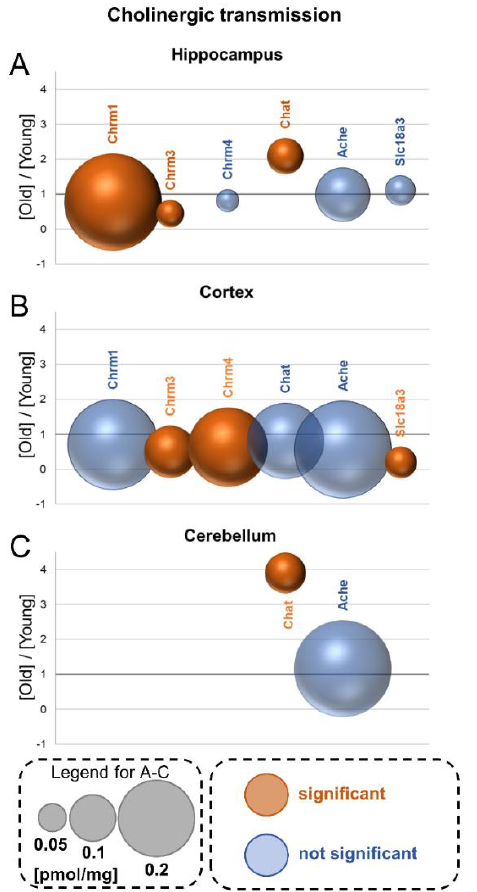
Figure 5. Aging - associated changes in cholinergic transmission. Plot shows the ratios of the titers of the receptors and proteins involved in acetylcholine metabolism in old vs. young brain formations in: hippocampus ( A ), cortex ( B ) and cerebellum ( C ). The size of bubbles is proportional to the average protein concentration in the respective old brain structures. Statistically significant differences are shown as the red